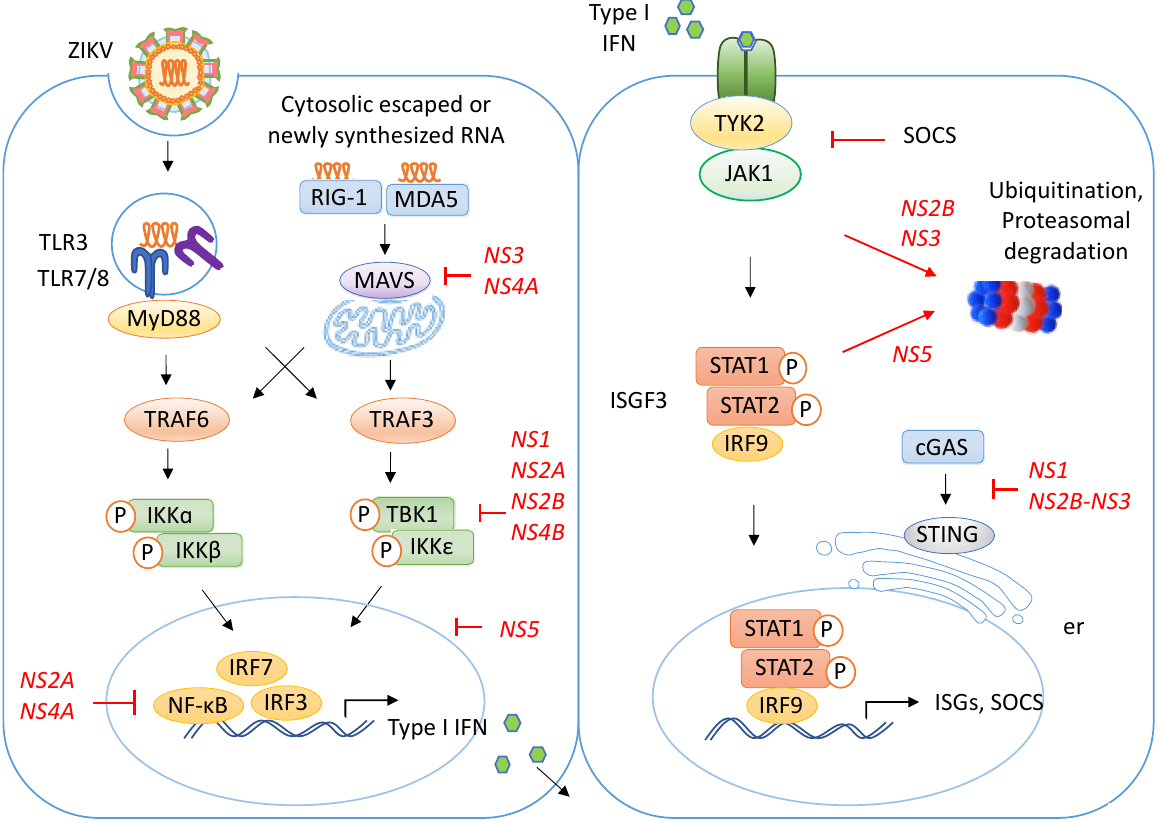
Figure 2. Immune recognition pathway in ZIKV-infected cells. The endosomal TLRs (TLR3, TLR7, and TLR8) and the cytosol RIG-like receptors (RIG-I and MDA5) recognize viral invasion through binding to ZIKV RNA. The TLRs activate MyD88, whereas RIG-I and MDA5 initiate the MAVS signaling cascade. These result in the activation of TRAF3 or TRAF6. TRAF6 subsequently activates IKK α and IKK β , which result in NF- κ B nuclear translocation and the transactivation of various immune-response-associated genes. On the other hand, TRAF3 causes TBK1 and IKK ε phosphorylation, which, in turn, activates IRF-3 and IRF-7 for the transactivation of type I IFN (IFN α and IFN β ). Type I IFN cytokines are released to stimulate antiviral defense in either an autocrine or a paracrine manner. The binding of secreted-type I IFN to its receptor leads to JAK1 activation, STAT2 phosphorylation, and the formation of the ISGF3 complex that is translocated into the nucleus to transcribe ISGs. The viral particles NS3 and NS4A inhibit MAVS migration to the mitochondria. NS1, NS2A, NS2B, and NS4B prevent the phosphorylation of TBK1. NS2A and NS4A suppress NF- κ B activity, while NS5 binds to IRF-3 and inhibits its transactivation activity. Furthermore, NS2B and NS3 suppress JAK1 signal transduction by inducing SOCS-dependent ubiquitination and degradation through the proteosome, whereas NS5 modulates the proteasomal degradation of STAT2, and, hence, the downstream signaling is prevented, repressing ISGs production. NS1 and NS2B-NS3 interrupt the cGAS/STING pathway to weaken the host immunity to ZIKV. Mitochondrial, mt; endoplasmic reticulum, er.